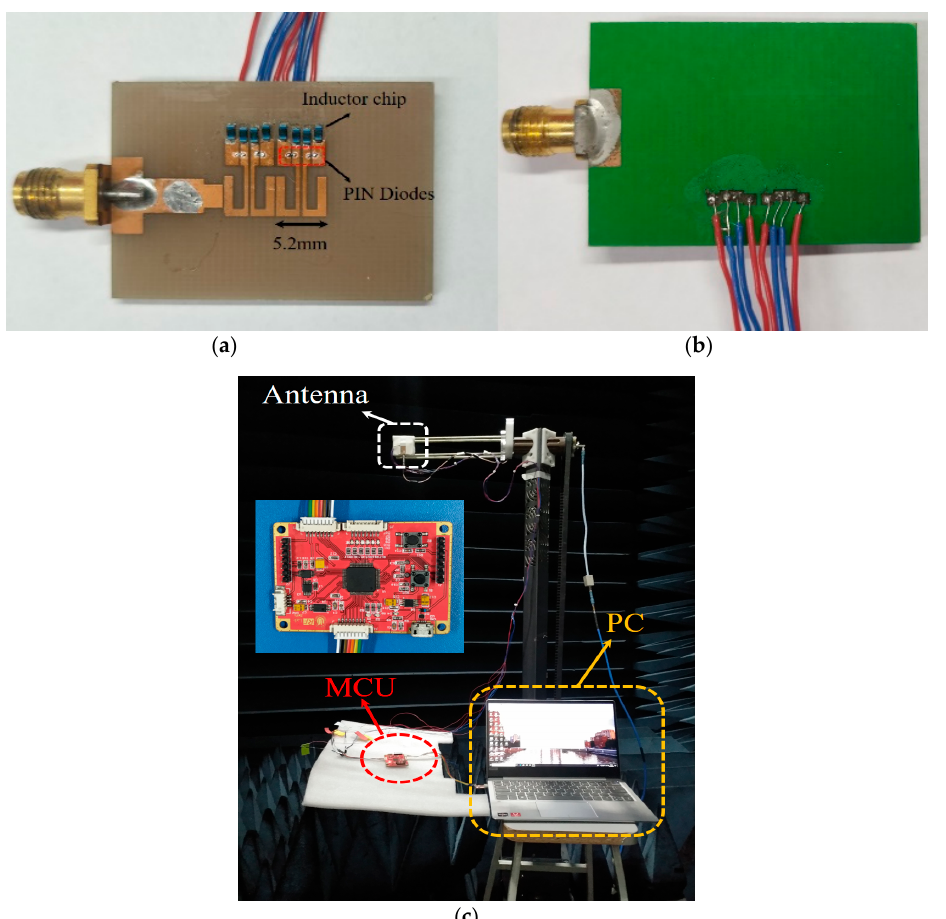
Figure 7. Fabricated MTM antenna includes ( a ) top view of MTM units with PIN diodes and inductor chips; ( b ) bottom view of four pairs of wires for DC voltage supply; ( c ) anechoic chamber measurements in which a PC controls the MCU for outputting DC voltages to PIN diodes.